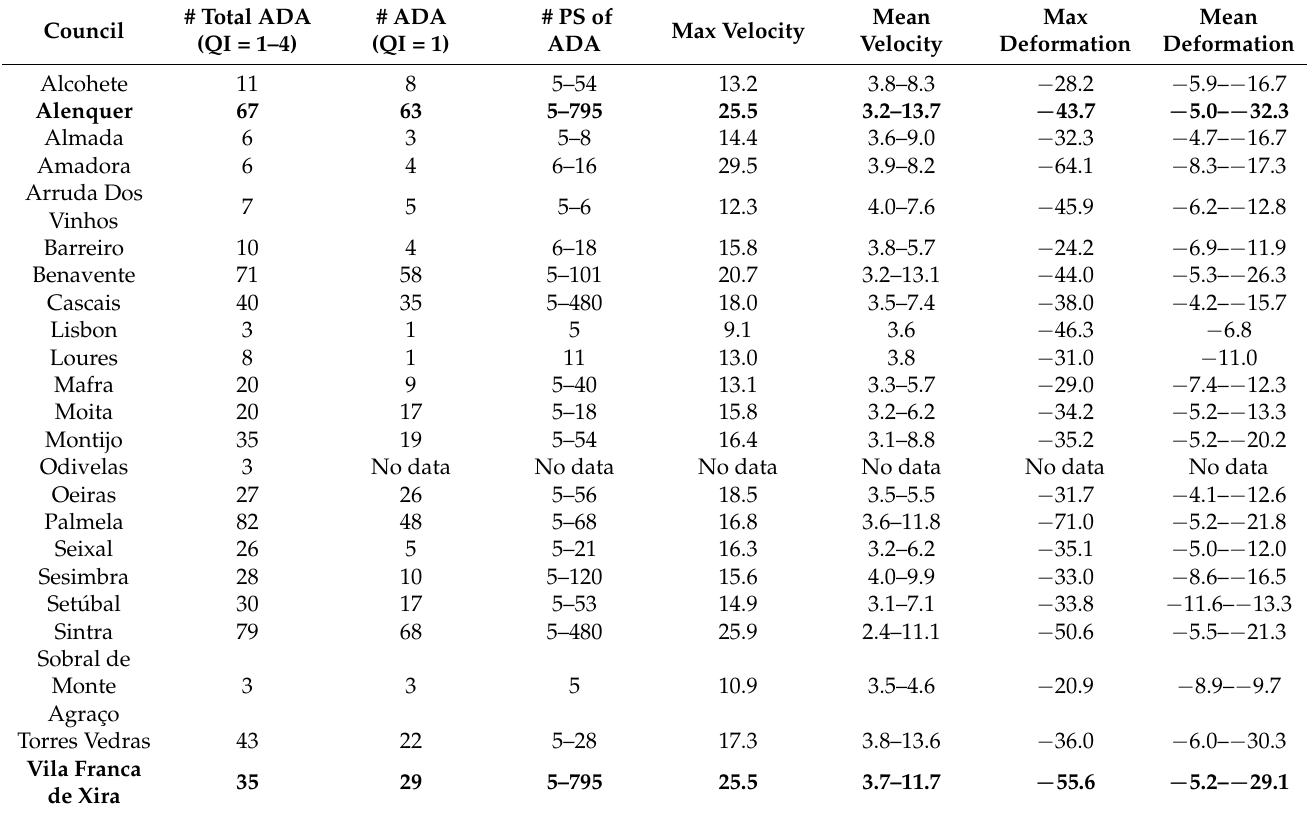
Table 4. Main parameters of ADA with QI = 1 for each council in ascending trajectory. Number of PS, velocity (mm year − 1 ), and deformation (mm) are shown according to the ADA with QI = 1. In bold are the councils corresponding to the local study